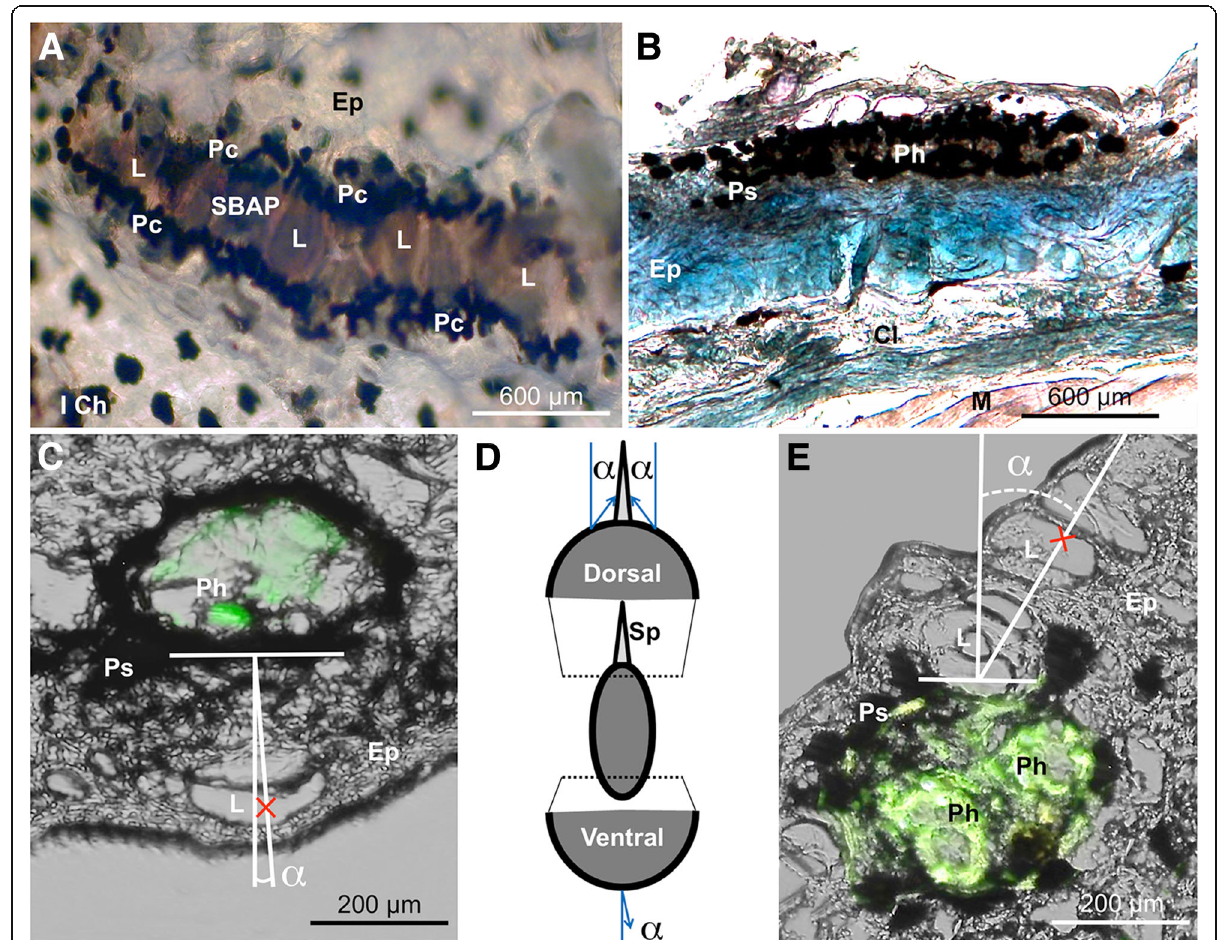
Fig. 3 Spine base associated photophore (SBAP) close up structure. a External view of SBAP showing lens cells and the pigmented crown. b Transversal section of SBAP showing the internal structure of this new photophore type. c Longitudinal section of ventral photophore with a mean inclination angle <3°. d Schematic shark illustration showing ventral and SBAP inclination angles ( e ) Longitudinal section of SBAP with a mean inclination angle ±35° turned toward the spine. Red crosses correspond to the center of the biggest lens cell; ɑ : angle; Ep: epidermis; I Ch: isolated chromatophore; Cl: connective layer; L: lens; M: muscle; Pc: pigmented crown; Ph: photocytes; Ps: pigmented sheath; Sp: